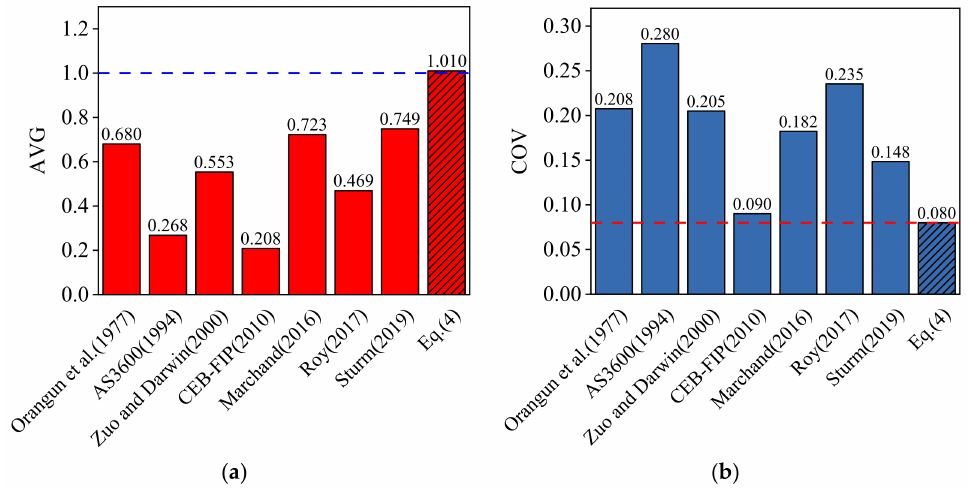
Figure 14. Comparative the calculated bond strength of steel bar in UHPC: ( a ) the average ratio; ( b ) the coefficient of variation.